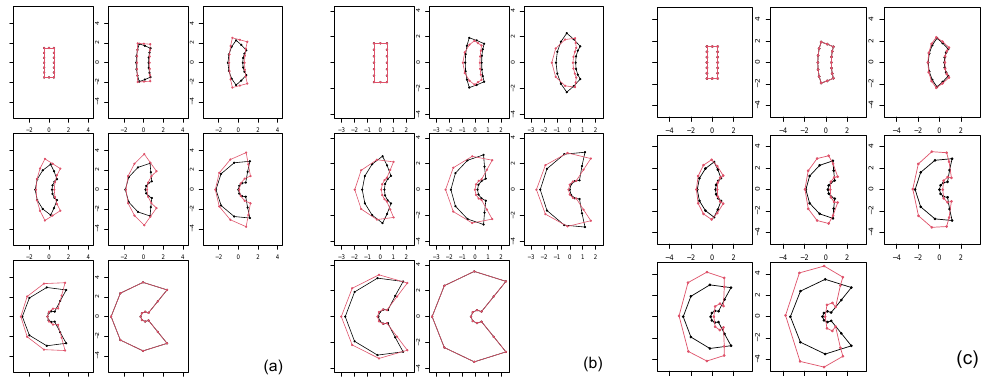
Figure 10. Non-affine case bending+size results. ( a ) Left panel: geodesic trajectory shapes (black) plotted against the original parametric shapes (red). ( b ) Center panel: geodesic trajectory shapes (black) plotted against the shapes found via linear interpolation between the first and last shapes of the parametric dataset (red). ( c ) Right panel: geodesic trajectory shapes (black) plotted against autoparallel trajectory (red) built via shooting of the first two configurations of the geodesic.